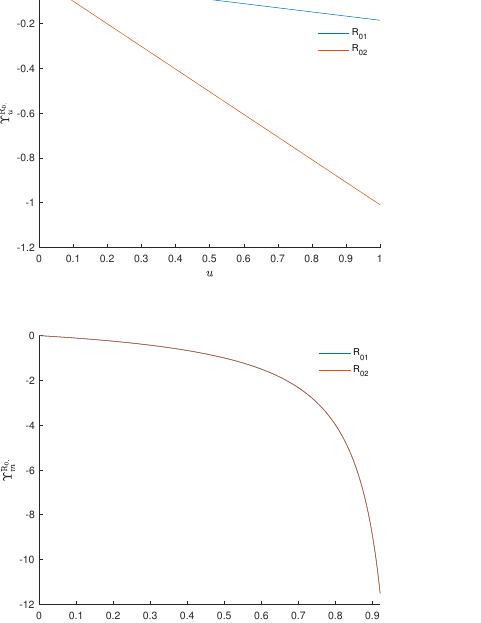
Figure 4. Sensitivity index of the basic reproduction numbers with respect to the control variables u ( top left ), v ( top right ), and m ( bottom